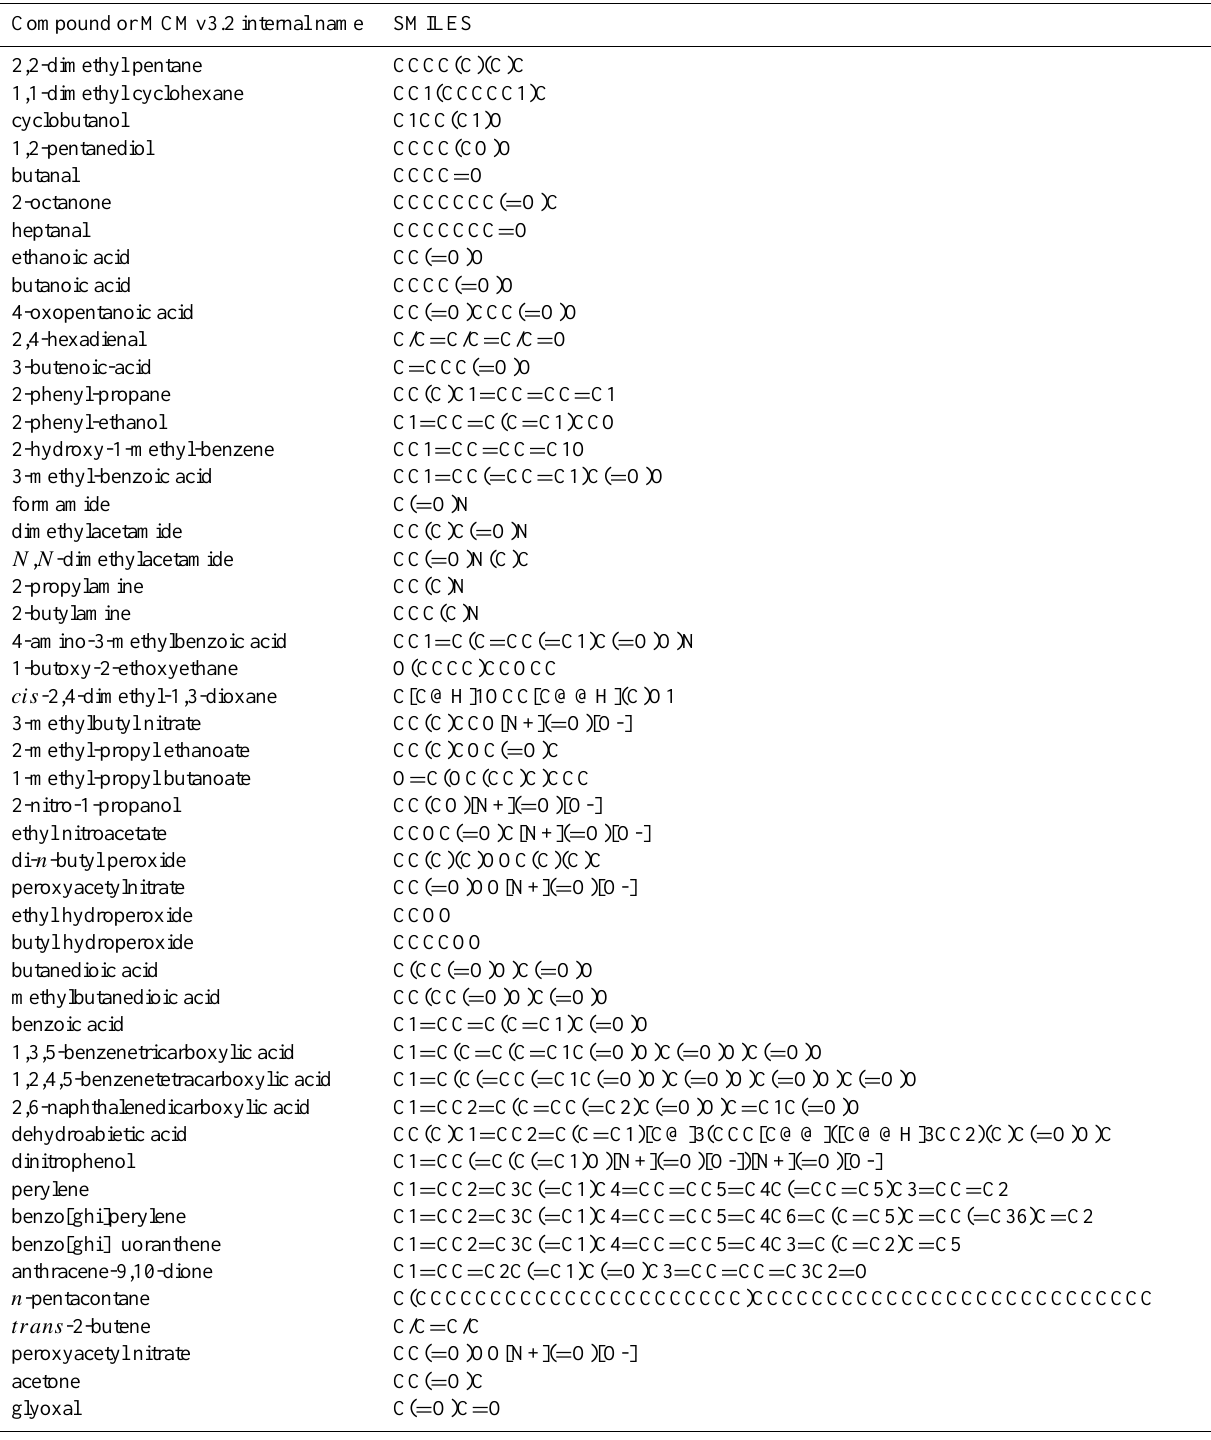
Table C1. List of the compounds used to test the chemoinformatic patterns used in the SIMPOL.1 (Pankow and Asher, 2008) group contri- bution method to calculate pure-component vapor pressure (Table